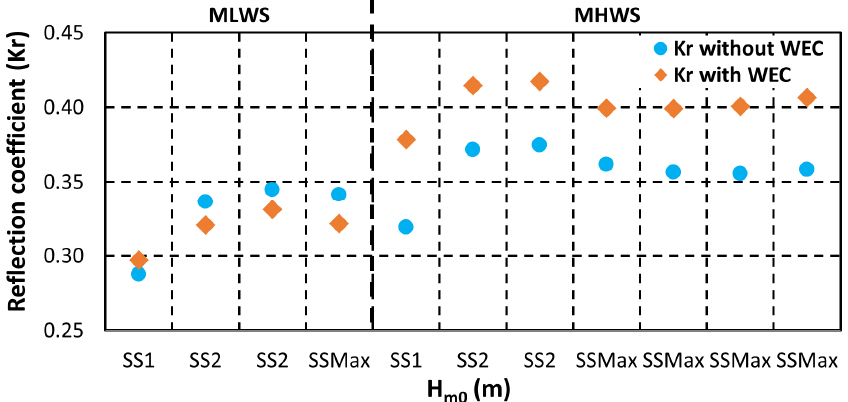
Figure 9. Reflection coefficients with and without the HWEC.